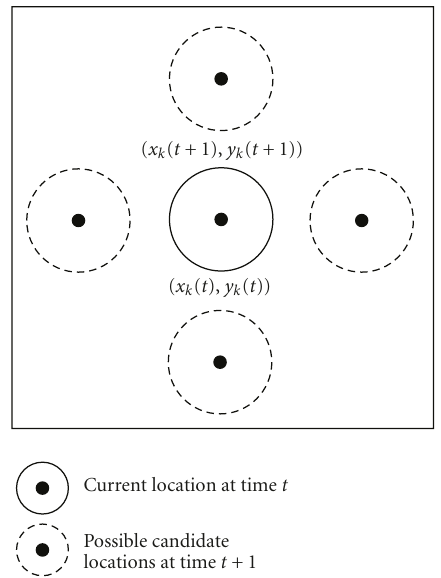
Figure 1: Candidate locations for a mobile node at time t